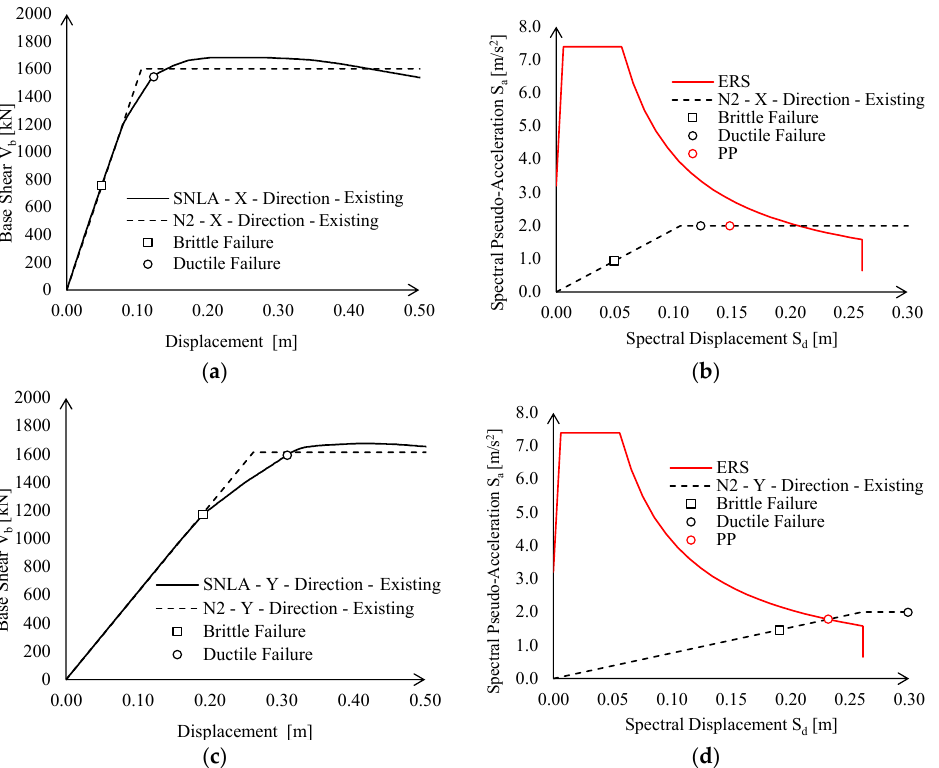
Figure 13. Global performance of existing structure in terms of pushover curves and ADRS domain checks according to EN1998:3 [31] provisions: ( a ) Pushover curves in X-direction, ( b ) ADRS domain checks in X-direction, ( c ) Pushover curves in Y-direction, ( d ) ADRS domain checks in Y-direction.